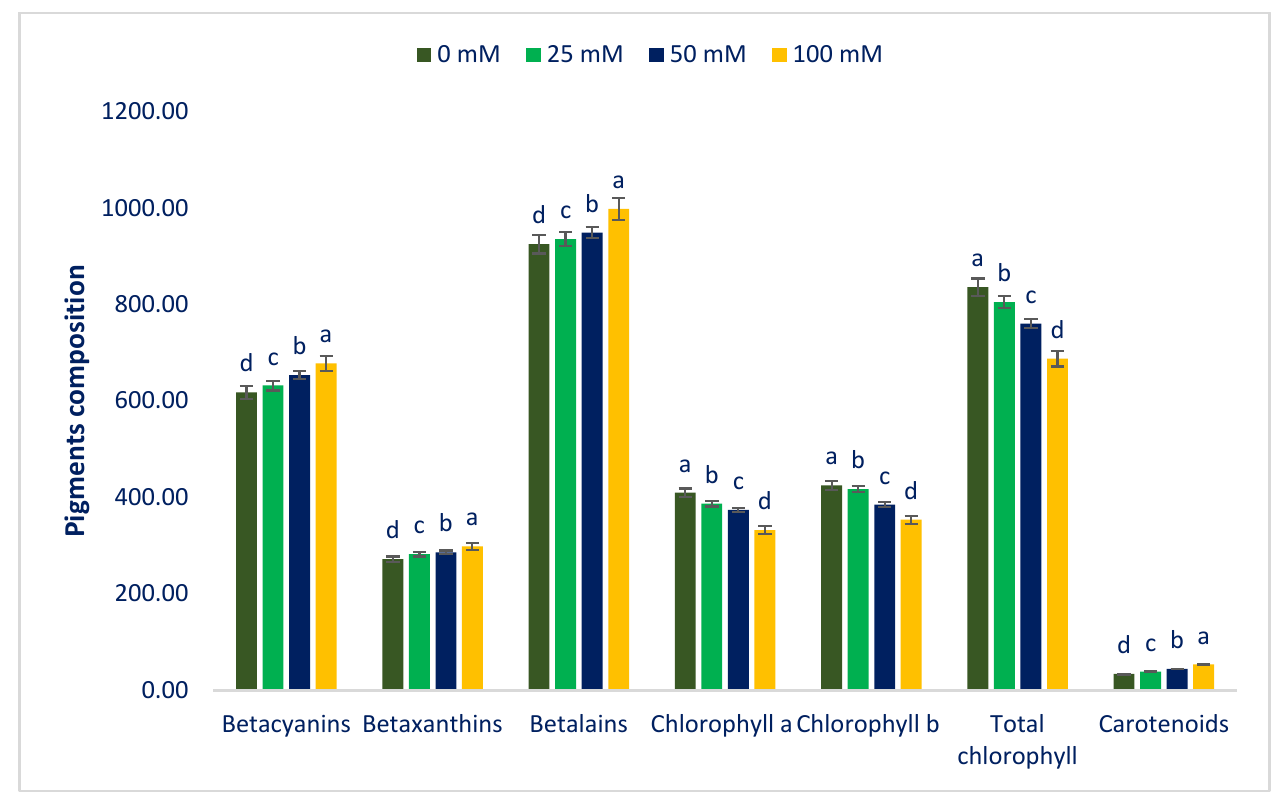
Figure 2. Pigments of Lalshak as influenced by salt stress ( n = 6). Dissimilar letters in the bars varied significantly by DMRT ( p < 0.01).